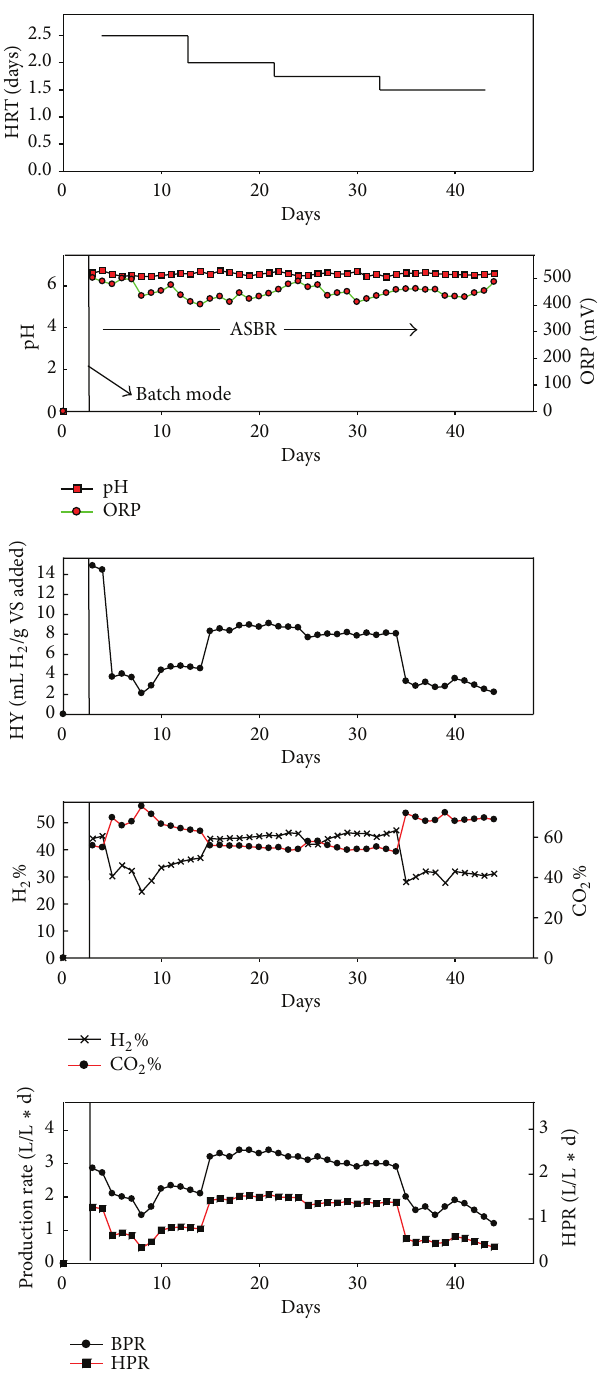
Figure 2: ASBR reactor performances.